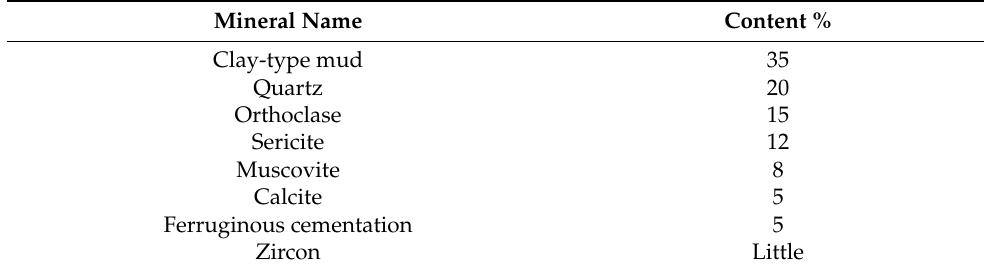
Table 1. The main mineral composition and its content of red shale.